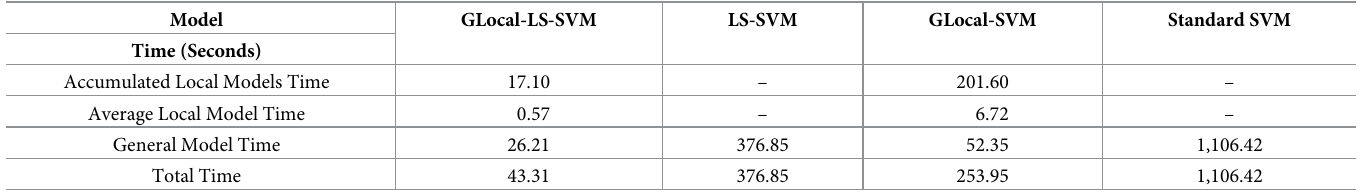
Table 10. Comparing the average time performance, in seconds, of the GLocal-LS-SVM model to the global LS-SVM model, Glocal-SVM, and standard SVM applied to the Daphnet FoG dataset.